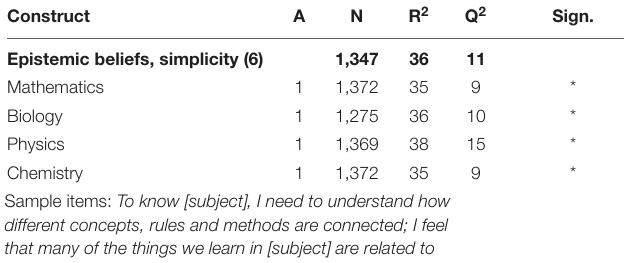
TABLE 1 | Performance of PCA models to validate